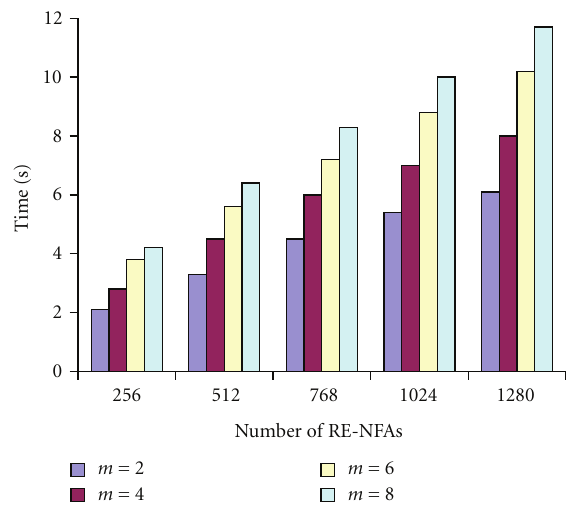
Figure 12: Clock frequency and LUT usage of group of 64-state synthetic REMEs versus number of REMEs implemented. Solid lines (left scale) are clock frequencies; dashed lines (right scale) are number of LUTs.